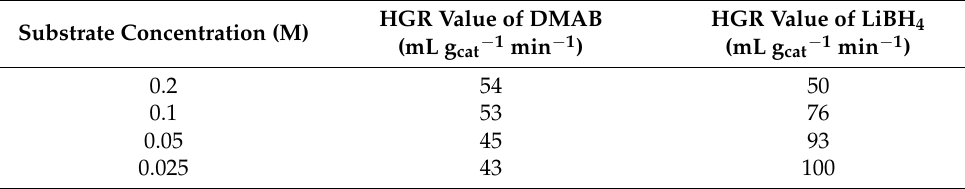
Figure 6. Plots of produced hydrogen volumes versus time for H 2 generation upon hydrolysis process under various initial concentrations of ( a ) DMAB experiments and ( b ) LiBH 4 experiments. HGR values calculated against each initial substrate concentration are given in Table 2. Table 2. HGR values with nickel catalyst at different substrate concentrations.